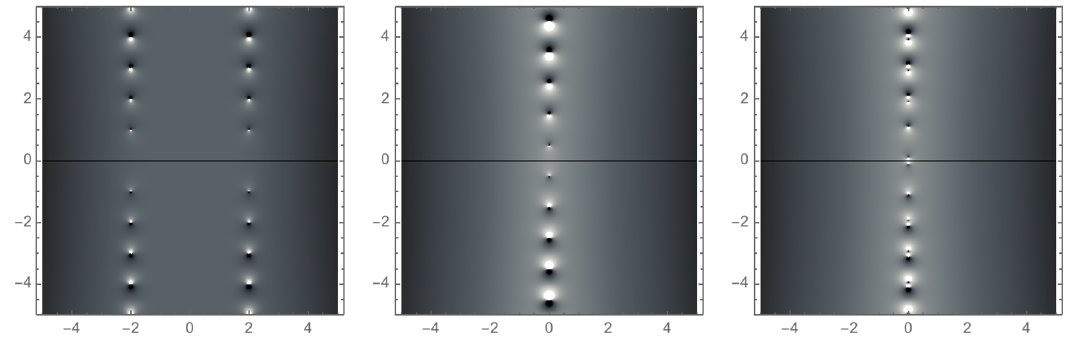
Figure 13 . Plot of | ρ ( ω ) | in complex ω -plane corresponding to the dS 3 examples of figure 10, that is ∆ = { 1 + 2 i, 1 − 2 i } , { 1 , 3 } , { 0 . 1 , 1 . 9 } , and 2Λ /π ≈ 64 . Lighter is larger with plot range ± 2 2 58 (black) < | ρ | < 67 (white). Resonance poles are visible at ω = ∓ i (∆